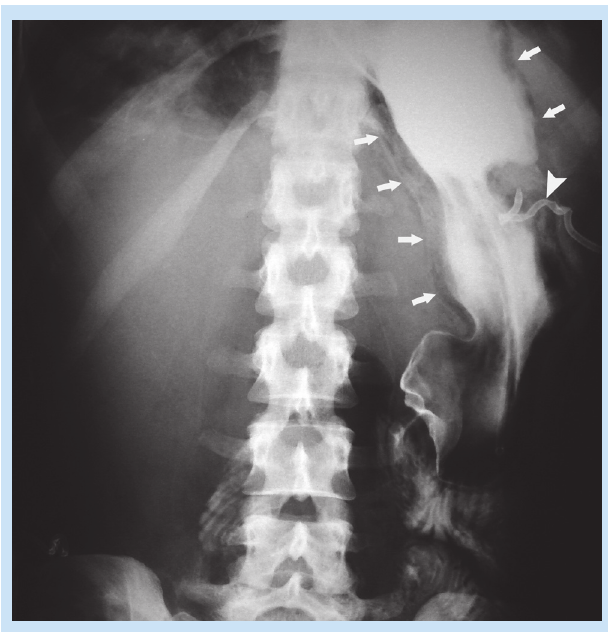
Fig. 2. Water-soluble contrast meal demonstrating intramural gastric air (arrows) and the left anterior subphrenic percutaneous drain